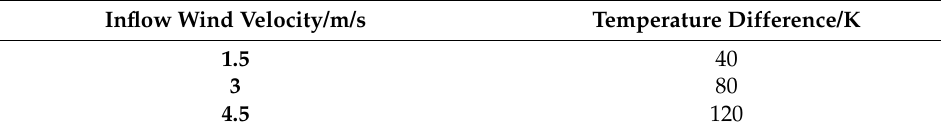
Figure 7. Temperature measuring points on the planes of ( a ) y = 0 m and ( b ) z = 0.033 m. Table 3. Sets of different boundary